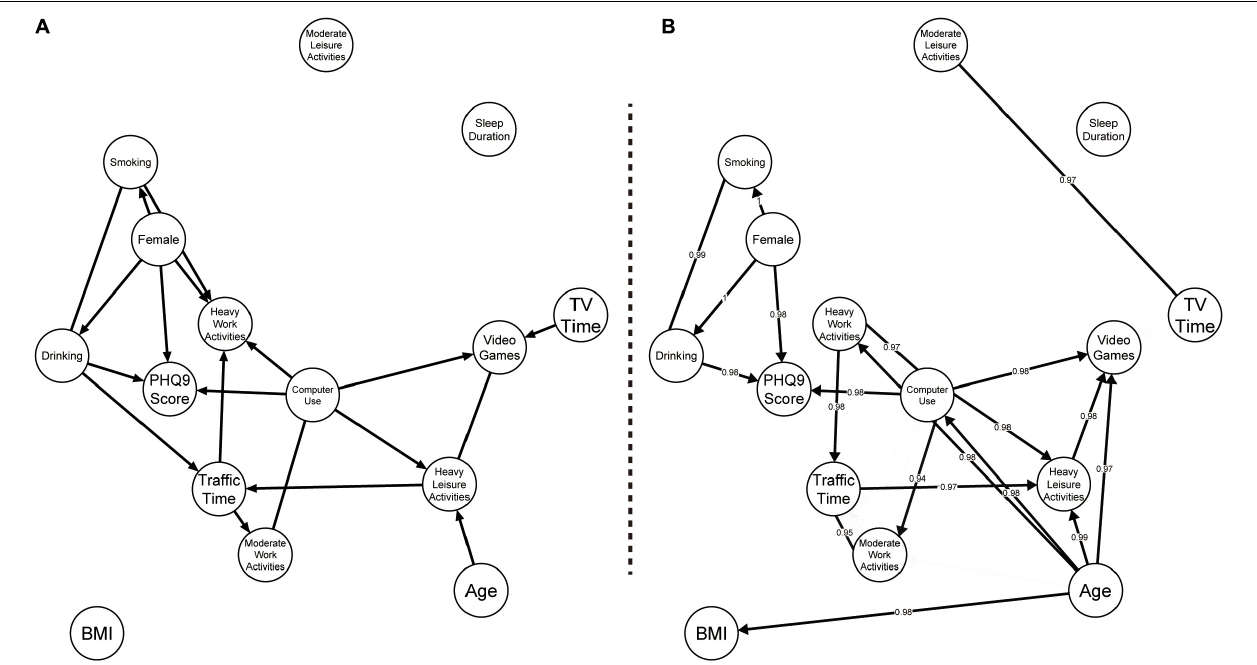
FIGURE 2 | Results of directed acyclic graph (DAG). (A) The initial estimated results of the DAG. (B) The results based on 1,000 bootstrap replications. Numbers on each edge indicate the non-zero proportions.